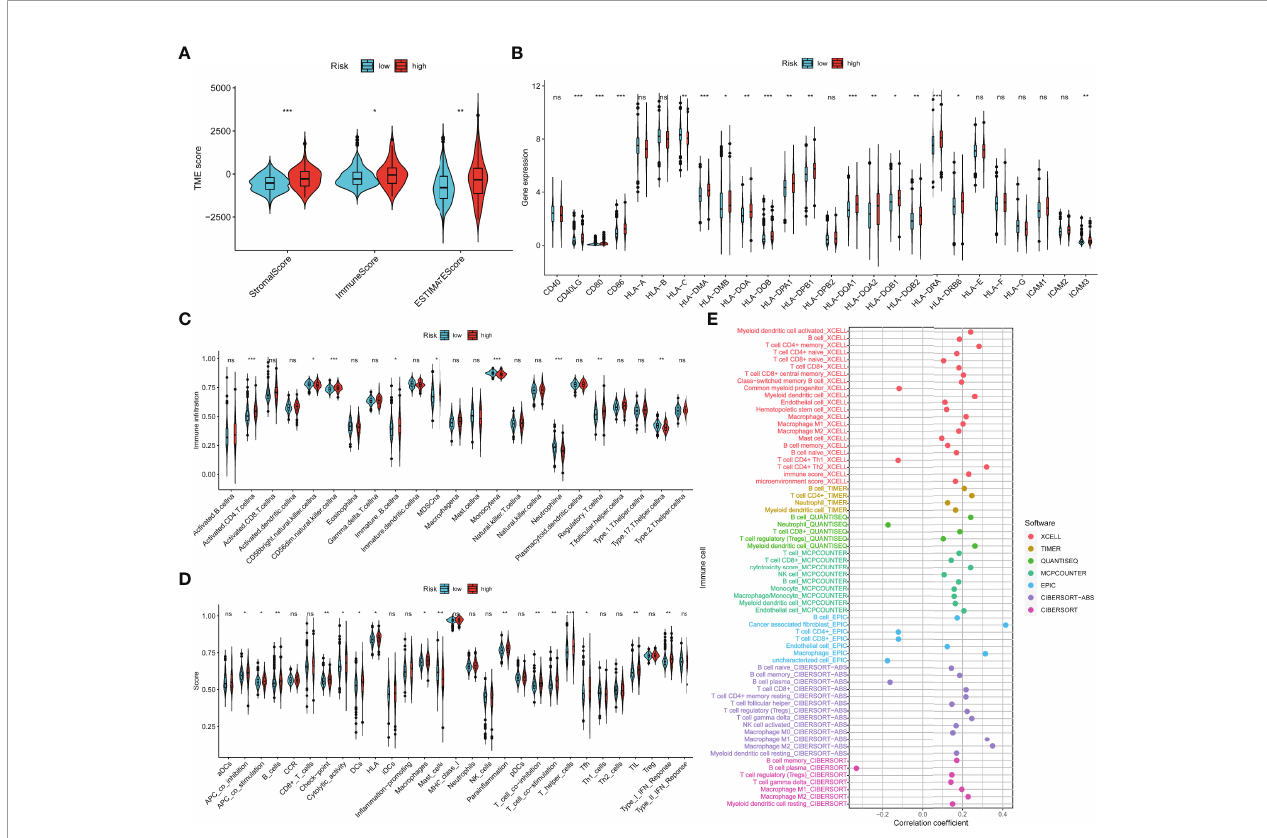
FIGURE 9 | Association between the TIME and m7G model. (A) The ESTIMATE of tumor microenvironment in the two m7Gscore-de fi ned groups. (B) MHC, costimulatory, and adhesion molecule expression in the m7Gscore-de fi ned groups. (C, D) Enrichment indices of TIICs (C) and immune functions (D) in the m7Gscore-de fi ned groups with ssGSEA. (E) Evaluation of the correlation between m7Gscore and the in fi ltration level of TIICs with comprehensive algorithms. TIME, tumor immune microenvironment; m7G, 7-methylguanosine; MHC, major histocompatibility complex; TIICs, tumor-in fi ltrating immune cells; ssGSEA, single-sample gene set enrichment analysis. *p < 0.05; **p < 0.01; ***p < 0.001. ns, no signi fi